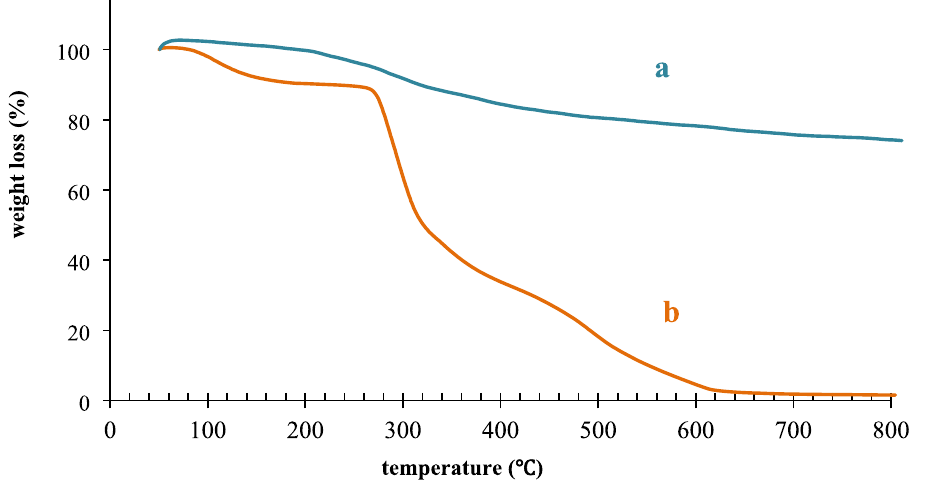
Figure 7. TGA of ( a ) the agar supported ZnS/CuFe 2 O 4 and ( b )